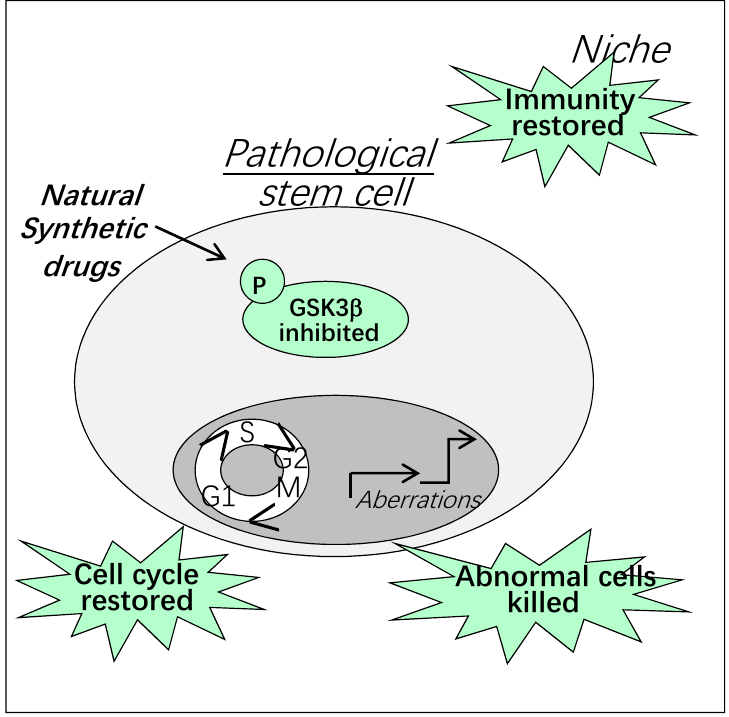
Figure 6. Therapeutic targeting of GSK3 in pathologic stem cells and their niche.